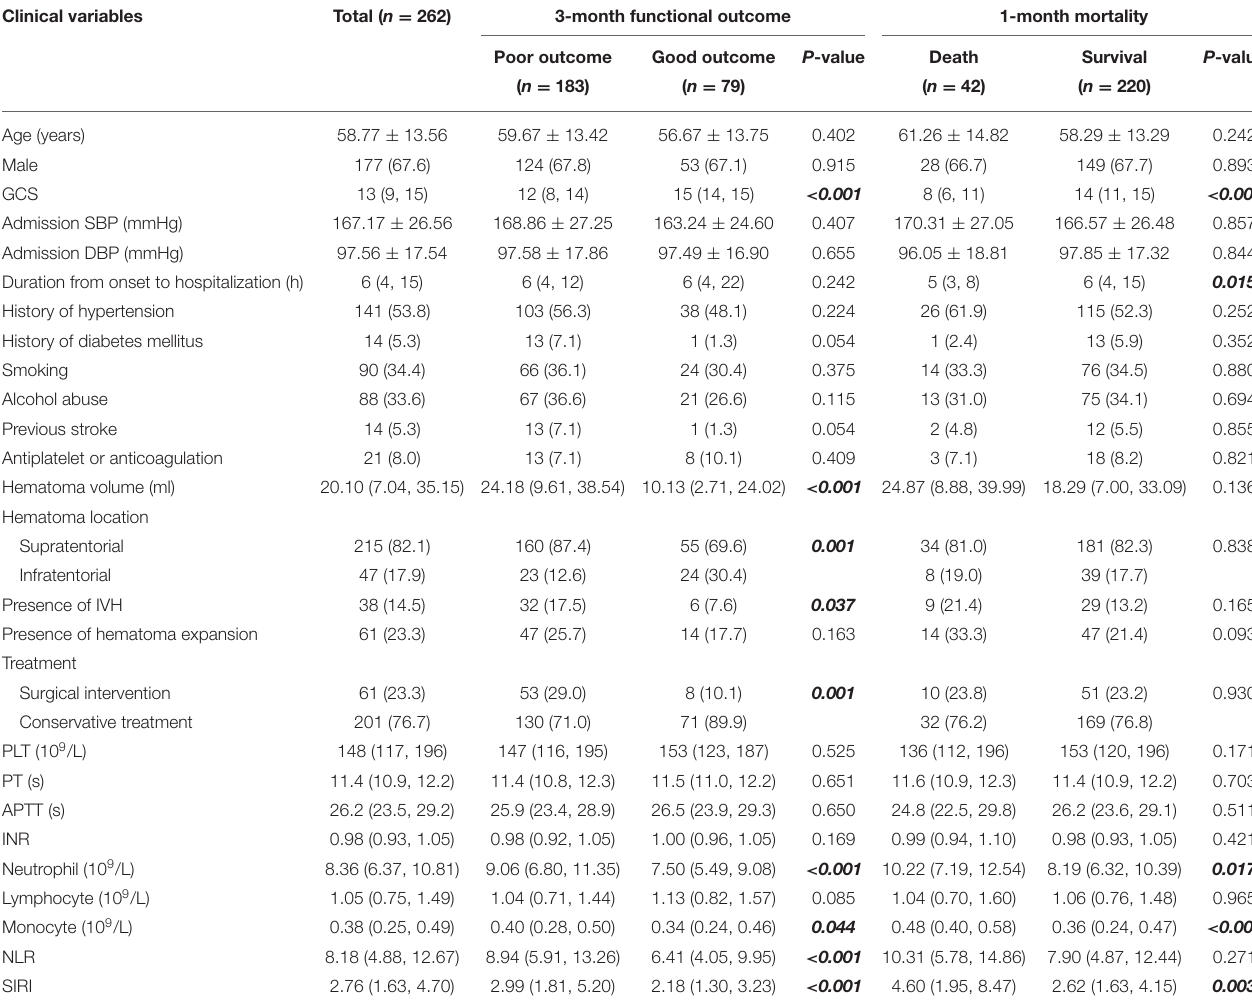
TABLE 2 | Baseline characteristics of 262 patients with spontaneous ICH in PSM cohort. Clinical